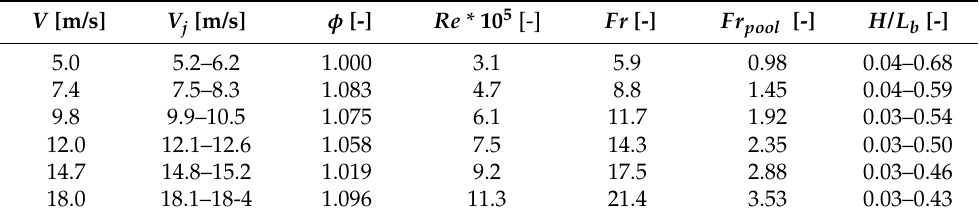
Table 2. Jet test conditions in terms of velocity at issuance V , at impact V j , kinetic energy correction factor φ , Reynolds Re , Froude Fr , Froude Pool Fr pool numbers and jet break-up length ratio H / L b .